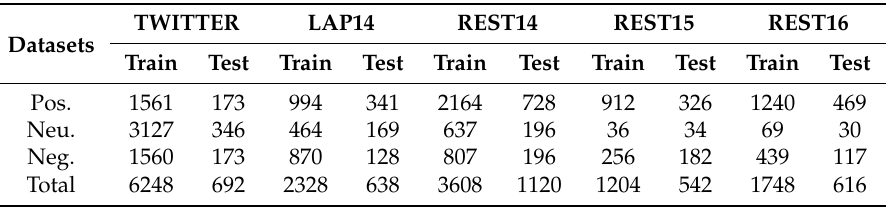
Table 1. Details of the benchmark datasets.